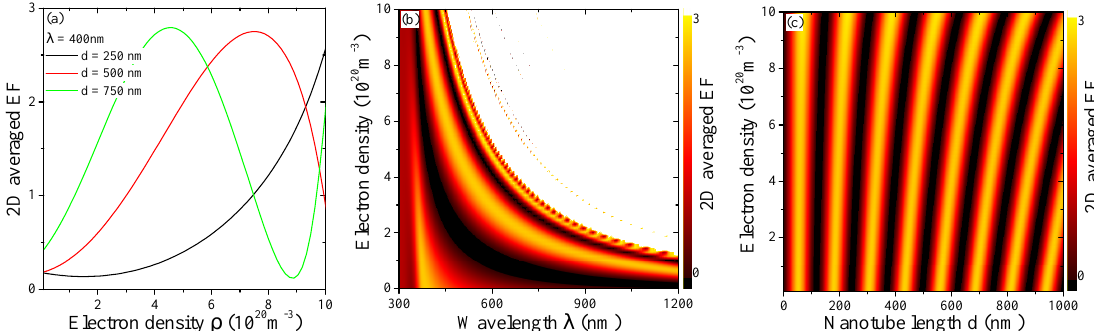
Figure 6. ( a ) Averaged enhancement factor as a function of the doping level of the system for a = 160 nm for several nanotube lengths and λ = 400 nm; ( b ) Contour presenting the data from ( a ) for full spectra; ( c ) Contour presenting the data from ( a ) as a function of nanotube length, cp. Figure